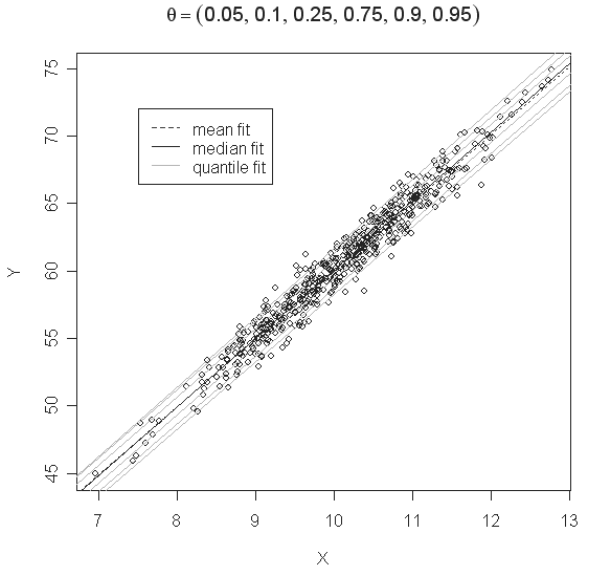
Figure 1 – QR estimates for an homogeneous error